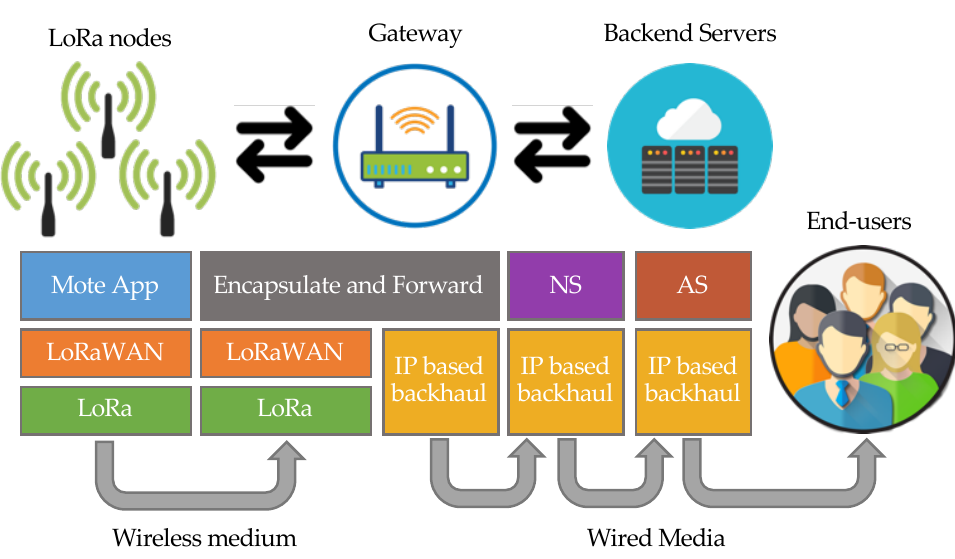
Figure 8. The LoRaWAN network architecture. NS: Network Server, AS: Application